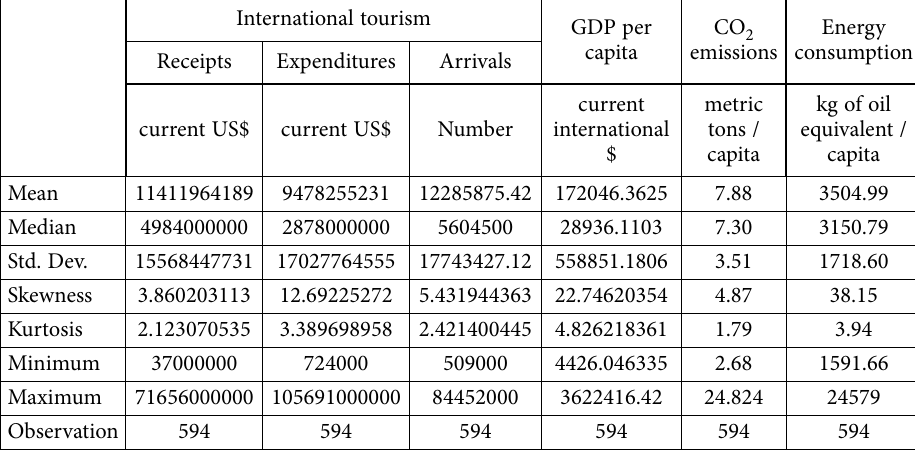
Table 1. Descriptive statistics (source: own computations based on data provided by The World Bank database,